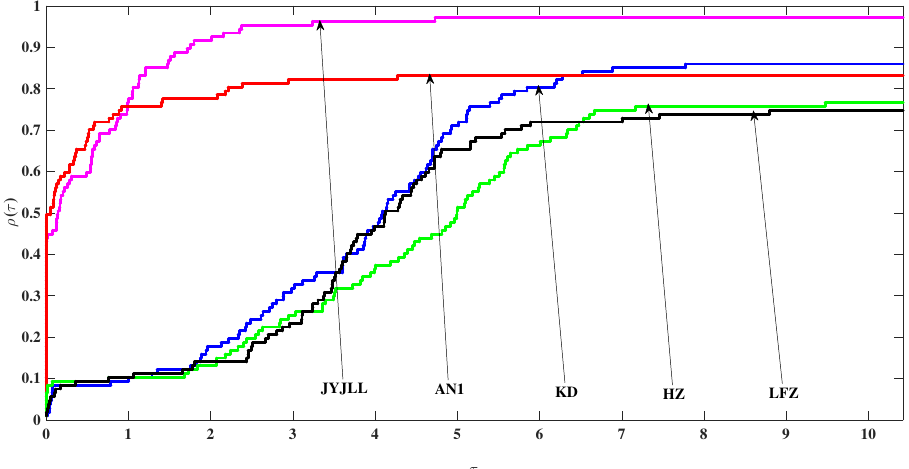
Figure 1. Performance profiles on